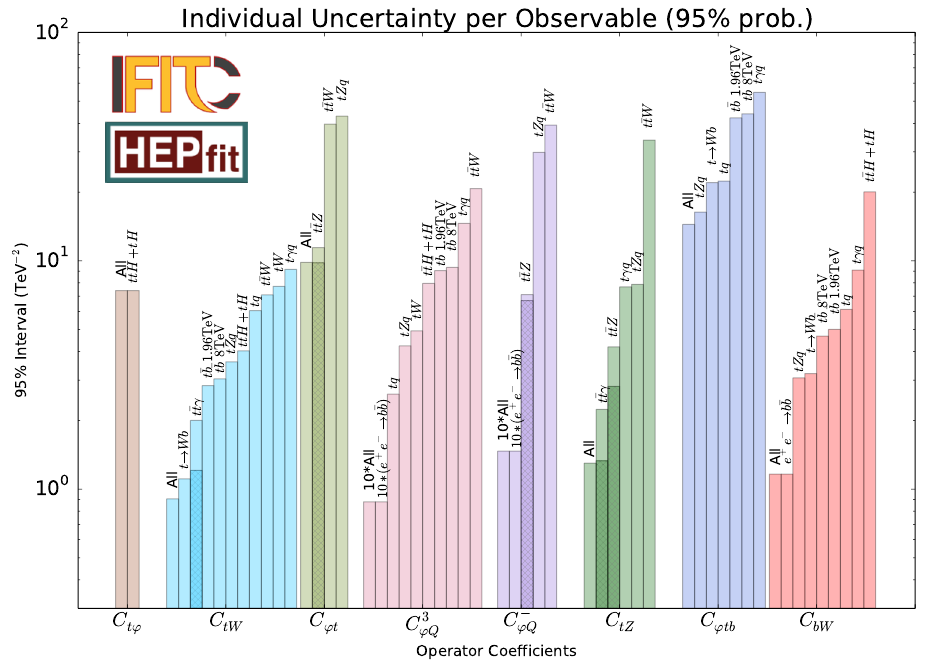
Figure 2 . Individual constraints on the eight Wilson coefficient resulting from measurements in different processes. The y-axis corresponds to the full width of the 95% probability interval for fits including Λ − 4 terms. The observables are set to their SM predictions, maintaining the experimental uncertainty. The dark shading indicates the bound from the t ¯ tγ and t ¯ tZ differential cross-sections. Besides QCD production, in the case of t ¯ tW process, the contribution of the electro-weak t ¯ tWq production is also